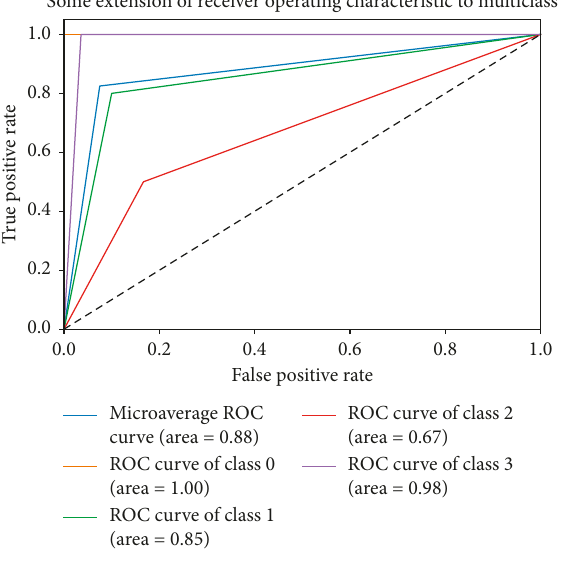
Figure 7: ROC analysis of ripening stage